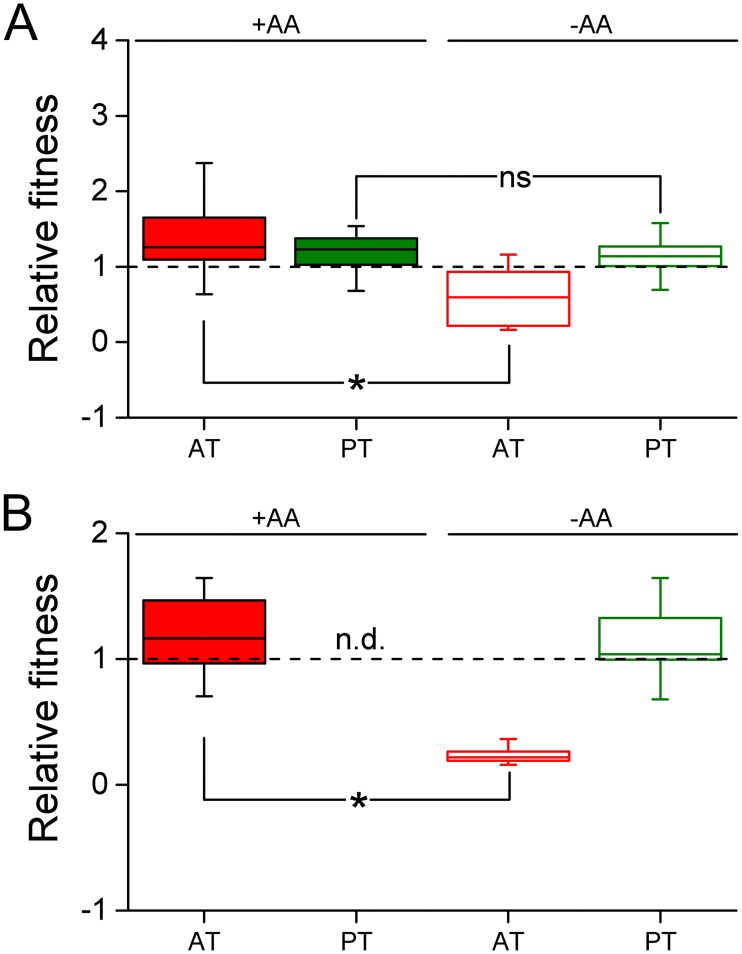
Fitness advantage of auxotrophs, but not prototrophs is AA-dependent.Competitive fitness of derived auxotrophs (AT, red boxes) or prototrophs (PT, green boxes) that evolved in (A) the presence or (B) the absence of AAs relative to their evolutionary ancestor was determined in the presence (filled boxes) or absence (empty boxes) of AAs. Relative fitness is the ratio of Malthusian parameters of each group of genotypes and the dashed line represents the fitness of the evolutionary ancestor. Asterisks indicate significant fitness differences between experimental conditions (independent samples t-test: P<0.05, n = 4 for 28 derived auxotrophic or prototrophic strains from the AA regime and n = 4 for 3 derived auxotrophic or prototrophic strains of each strain from the non-AA regime), while ‘ns’ denotes non-significant differences. The relative fitness of both derived types (AT and PT) differs significantly from that of the ancestor under both conditions considered (independent samples test: P<0.05, n = 4). ‘nd’ indicates the corresponding value was not determined. Box plots: medians (horizontal lines within boxes), interquartile range (boxes), and 1.5x-interquartile range (whiskers).